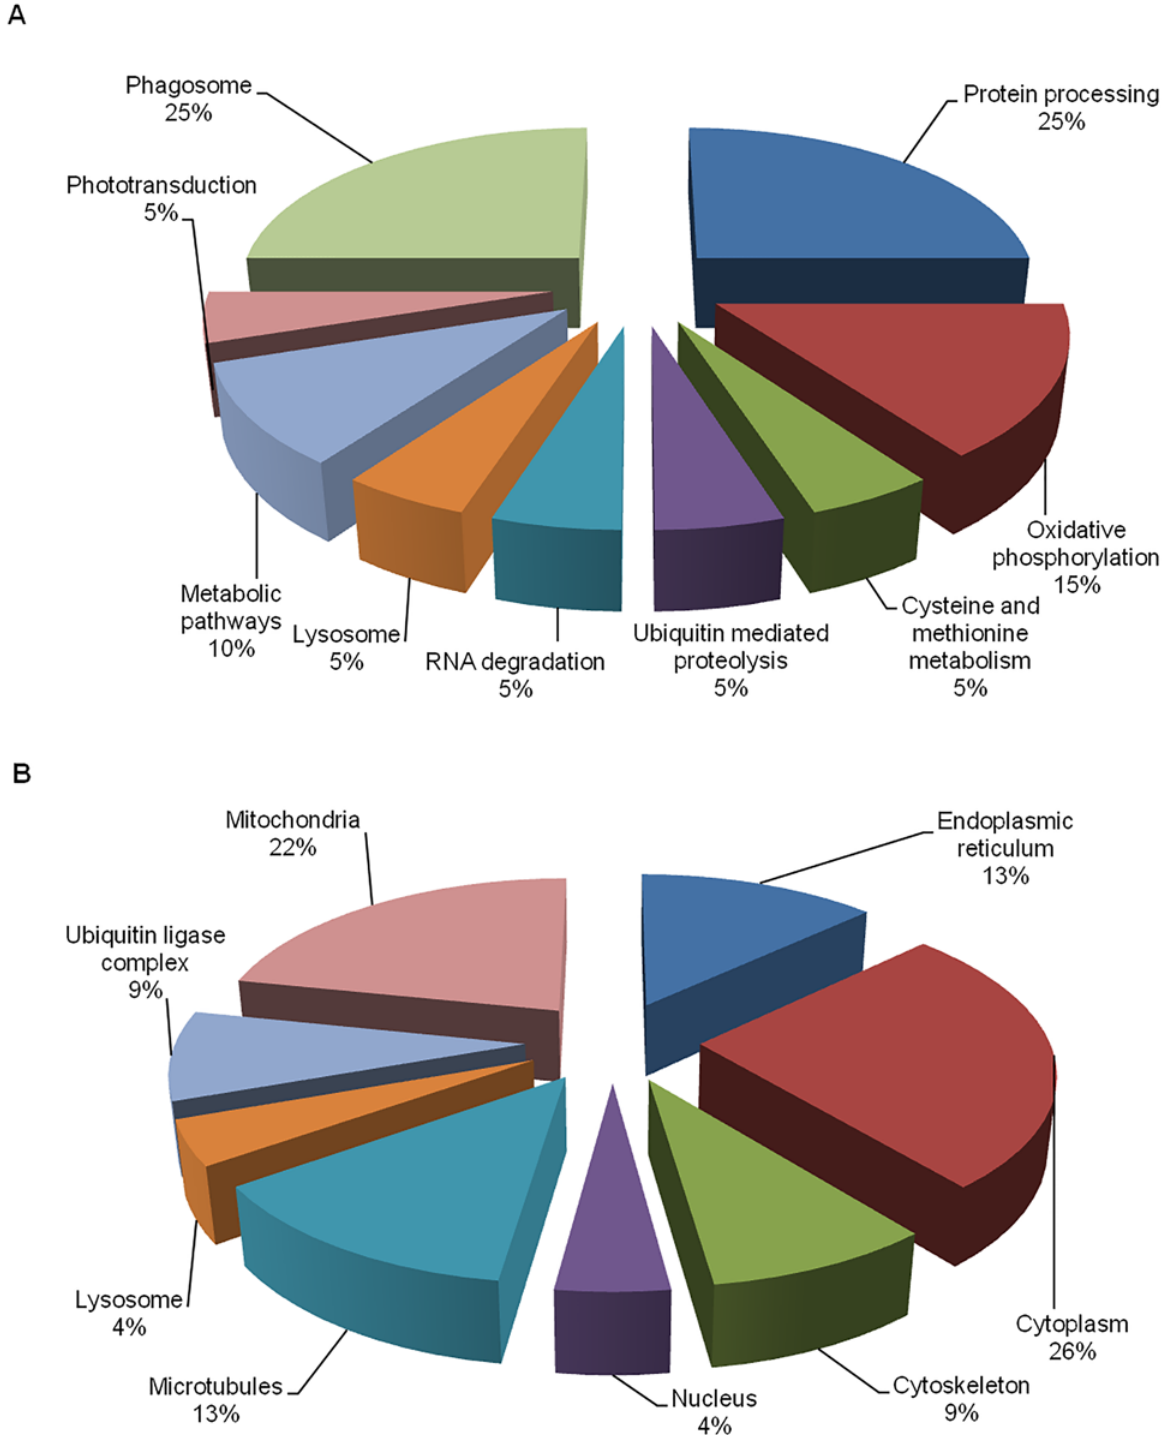
Fig 4. Cellular localization and functions of the differentially expressed proteins identified through 2-DE dynamic profiling. (A) The cellular localizations were determined using UniprotKB database. Most of the identified proteins were found in cytoplasm, and they mainly participate in protein processing. (B) The functions of each protein were determined using KEGG pathways